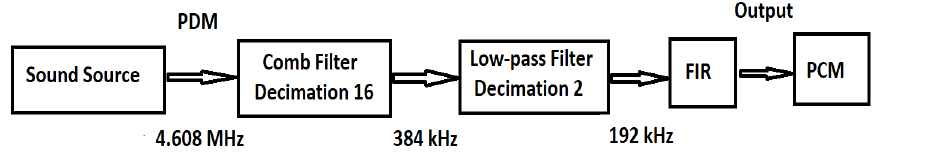
Figure 13. The acoustic processing system.